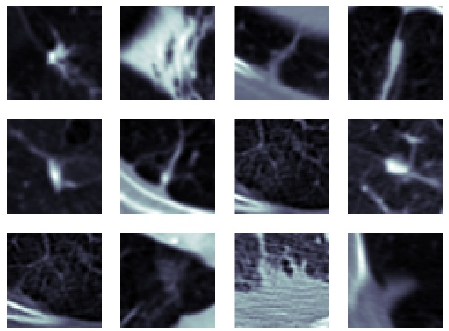
Figure 24. SFMPF model based on Trilateral image—missed non-nodules (FP).